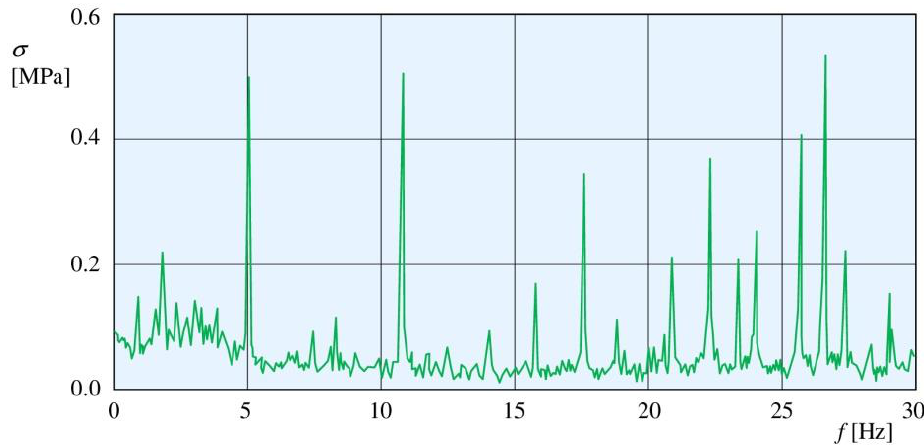
Figure 9. Amplitude spectrum of strains converted to uniaxial tension.